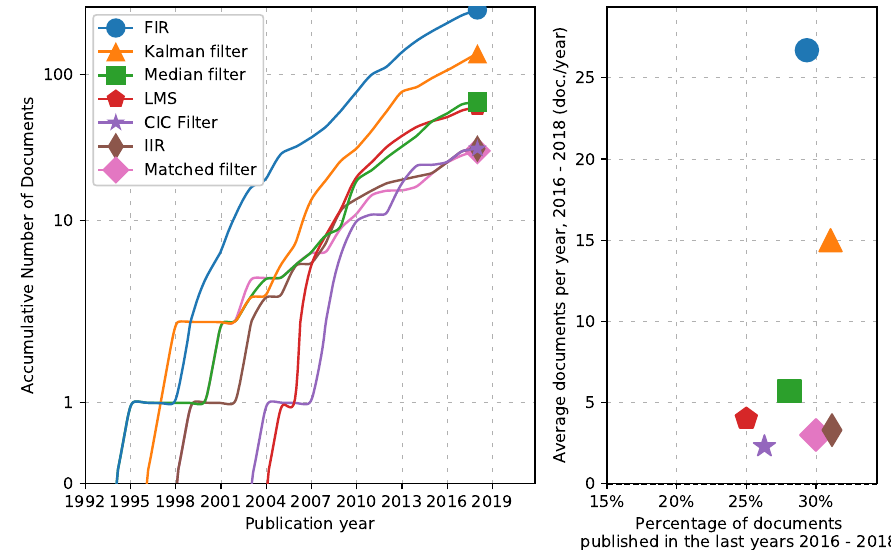
Figure 11. Digital filters top implementations in FPGA